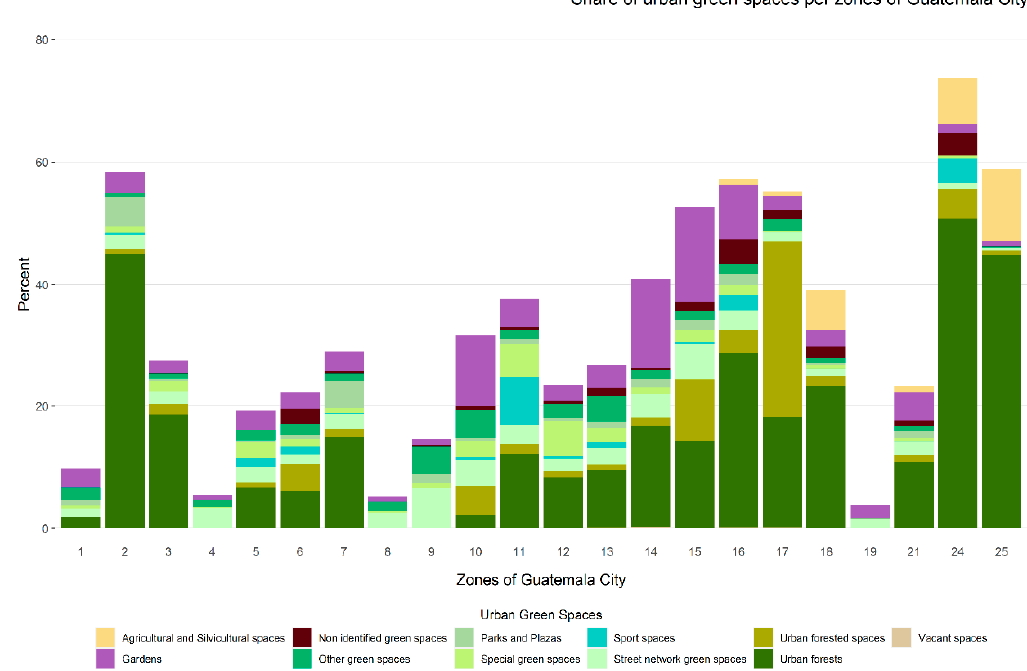
Figure 6. Percentage of Urban Green Spaces types per zones in Guatemala City. Each bar represents total green spaces in the zone and each color the share of each type. Description of each urban green space type is in Table 1.